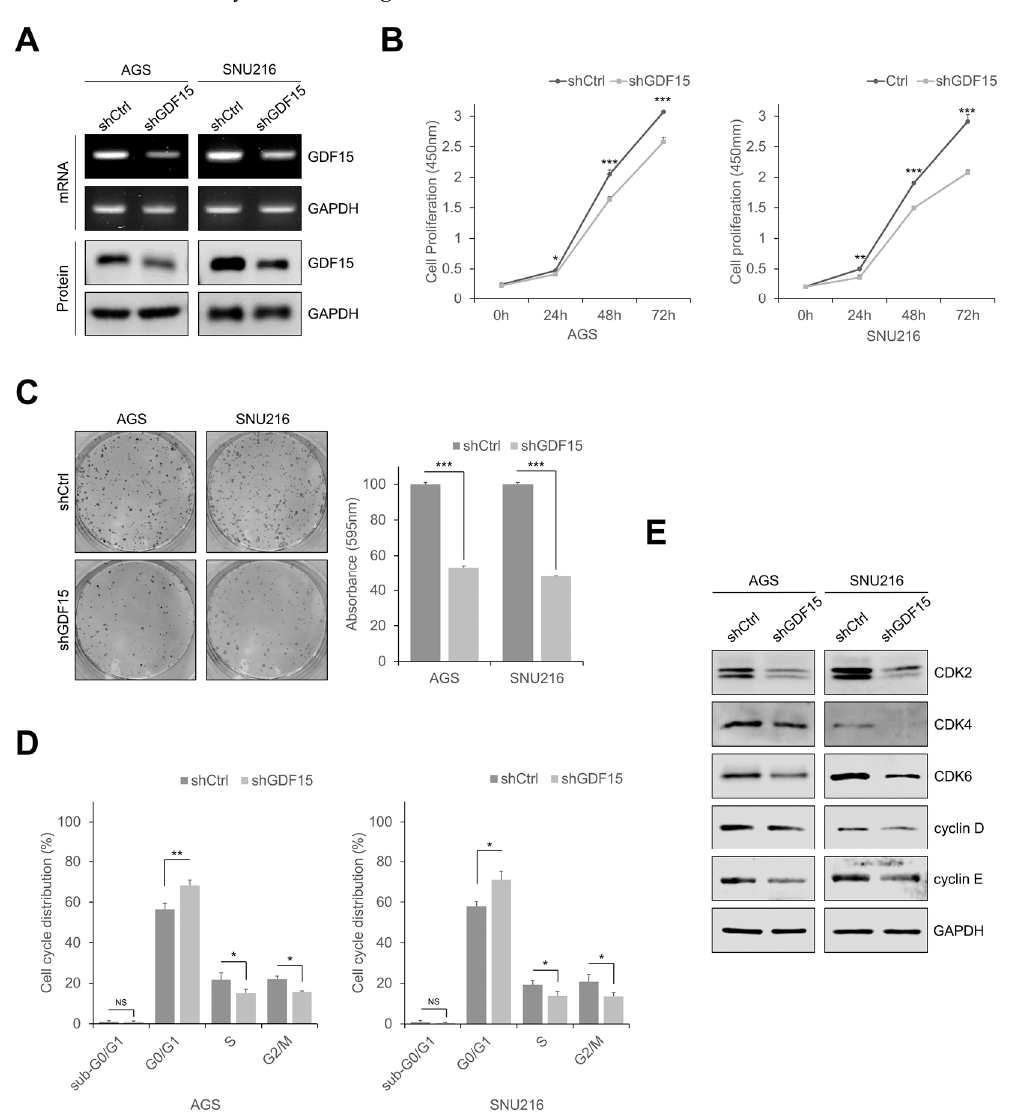
Figure 2. Knockdown of GDF15 inhibits cell growth by inducing cell cycle arrest. ( A ) Western blotting and RT-PCR analyses of GDF15 in GDF15-knockdown and shCtrl cells. ( B ) Cell proliferation rate as measured by cell counting analysis in GDF15-knockdown and shCtrl cells, and absorbance was measured at 450 nm using a spectrophotometer. Data are presented as the means ± SD and were evaluated using Student’s t -test ( n = 3). ( C ) The colonogenic assay was performed on a 6-well culture plate in GDF15-knockdown and shCtrl cells. Cells stained with crystal violet were dissolved in 70% alcohol, and absorbance was measured at 595 nm using a spectrophotometer. The data are presented as the means ± SD and were evaluated using Student’s t -test ( n = 3). ( D ) Cell cycle analysis of GDF15-knockdown and shCtrl cells by flow cytometry and the percentage of cells in sub-G0/G1, G0/G1, S and G2/M phases are annotated in each column. Data are presented as the means ± SD and were evaluated using Student’s t -test ( n = 3). ( E ) Western blotting analysis showing the expression of cell-cycle-related proteins. NS, not significant. * p < 0.05, ** p < 0.01, and *** p <